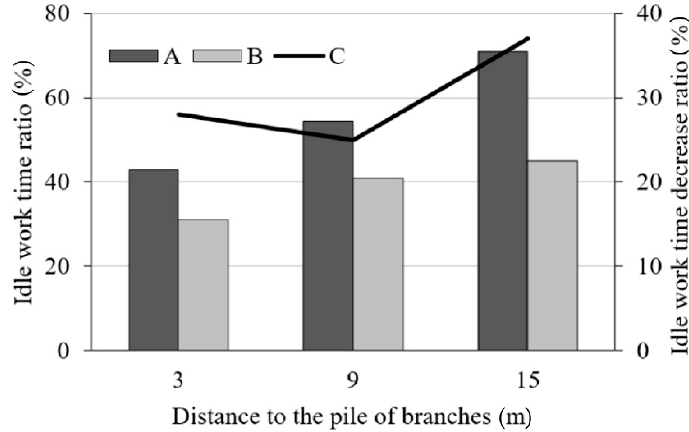
Figure 4. Characteristics of signal changes in the detection system in the feeding chute depending on conditions of branch supply; high level stands for presence of material for chipping, low level means it lacks; A—3 m distance and one operator, B—3 m distance and two operators, C—9 m distance and one operator, D—9 m distance and two operators, E—15 m distance and one operator, F—15 m distance and two operators. Table 1. Percentage of idle run time during chipping processes and frequency of operating condition changes.